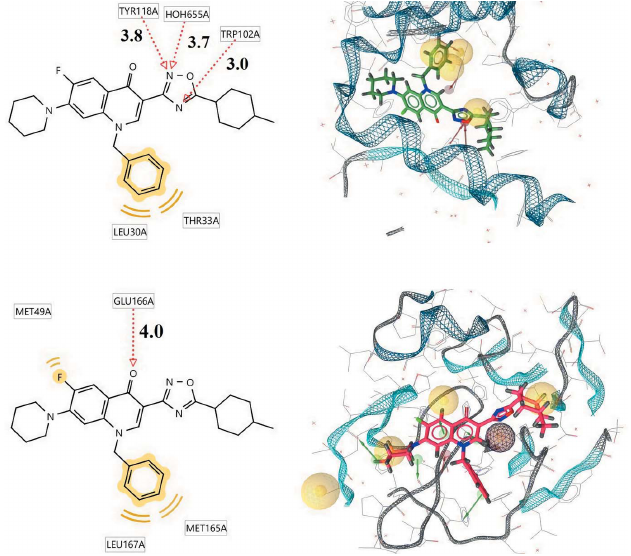
Figure 8 Interactions (on the left) and configuration of the title compound (on the right) within the active centers of target viral macromolecules (5E0I – at the top, 6LU7 – at the